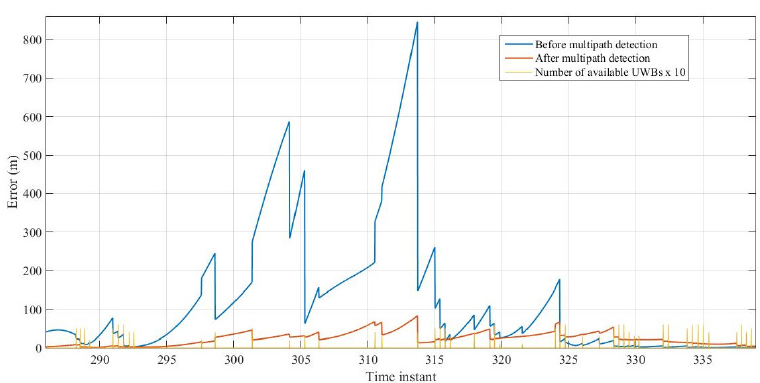
Figure 28. View2: Zoomed view of Figure 26.